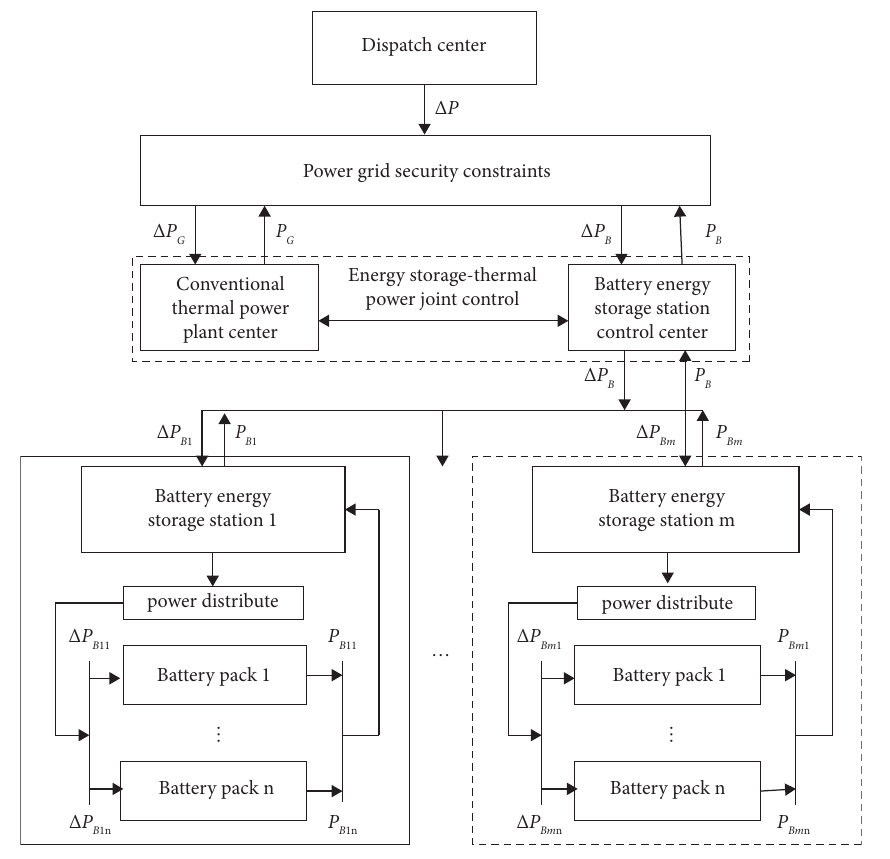
Figure 8: Battery energy storage-thermal power coordinated frequency regulation